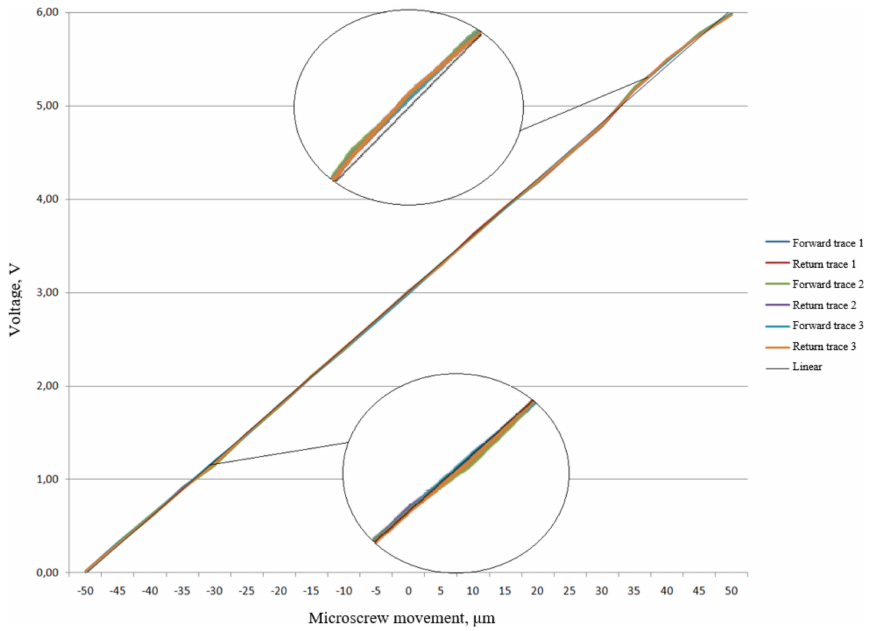
Figure 13. Dependence of the output signal from the ICU on the micro-displacement of the cylindrical lens.